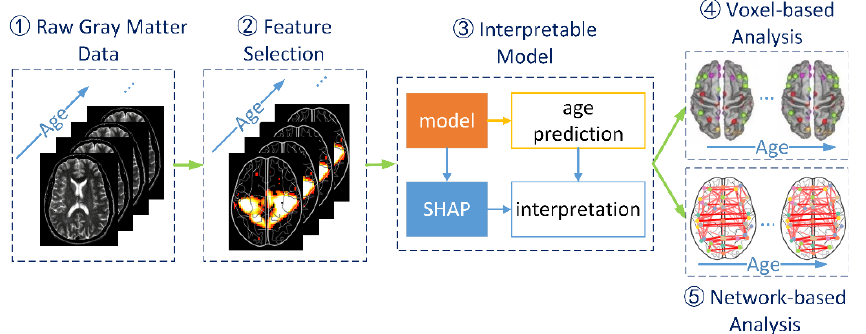
Figure 1. Workflow of the proposed method. The entire process is divided into five parts, starting with raw data preparation and feature selection, which is a data pre-processing stage. Then there is the interpretable machine learning model, which is tasked with achieving age prediction while providing interpretable parameters for subsequent analysis. Finally, for individuals, voxel-based and network-based analyses are implemented, as well as their dynamic evolutionary characteristics.